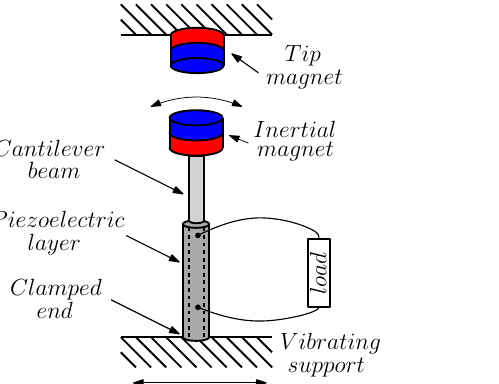
Figure 10. Schematic representation of a cantilever beam bi-stable piezoelectric energy harvester. Conversely, when the distance between the two magnets is small enough, the system is subject to a nonlinear elastic force. Magnetic repulsion forces the beam to the left or to the right of the vertical position. The unforced system exhibits bi-stability, with two stable equilibrium points, each with its own basin of attraction, separated by an unstable saddle, corresponding to the vertical rest position. For small external forcing, the beam oscillates either around the left or the right equilibrium position (see Figure 11, on the left), depending on the initial condition. For small amplitude oscillations, the system can still be described in terms of a linear oscillator, with a resonant frequency higher than in the previous case [19], and the stationary distribution shows two well separated peaks located around the stable equilibrium points (Figure 11, right).